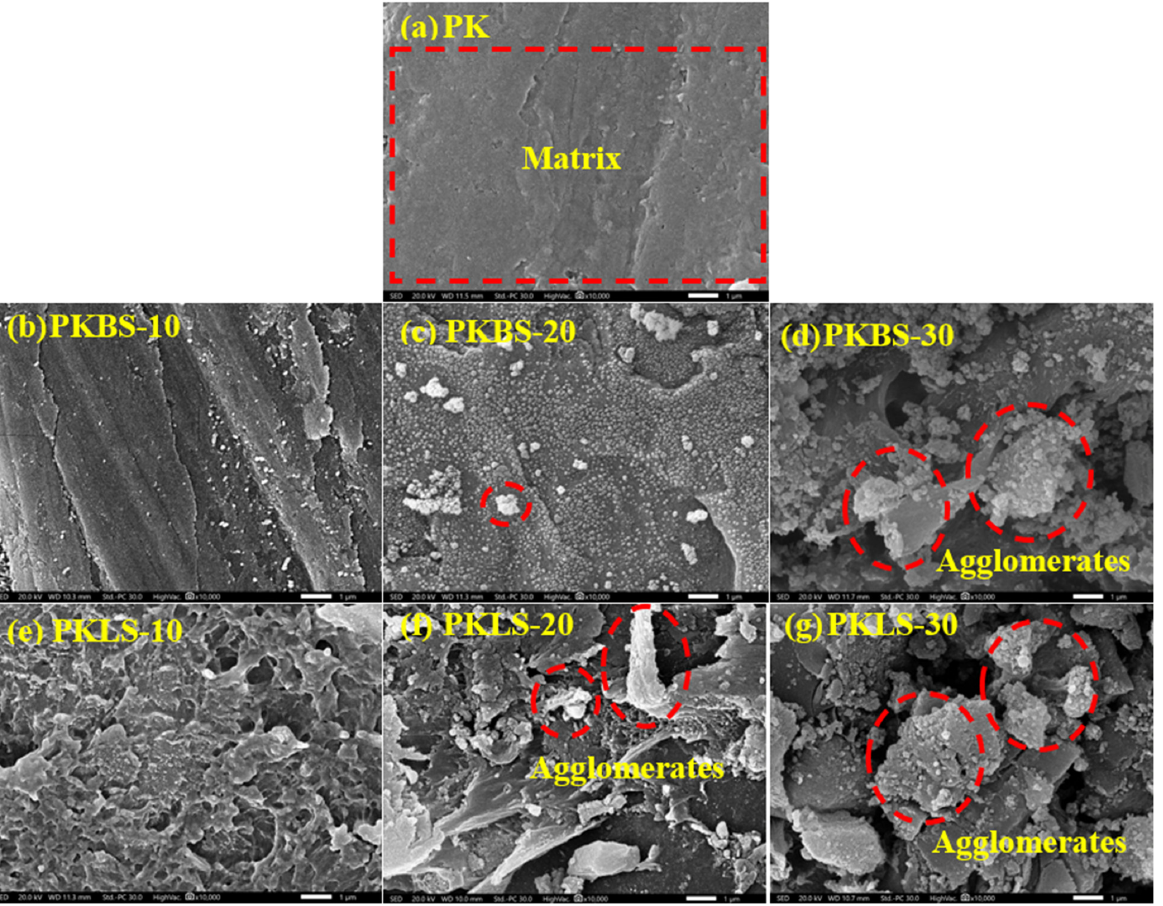
Figure 2. SEM micrographs showing the dispersion of the nano-SiO 2 fillers in the PEEK matrix.